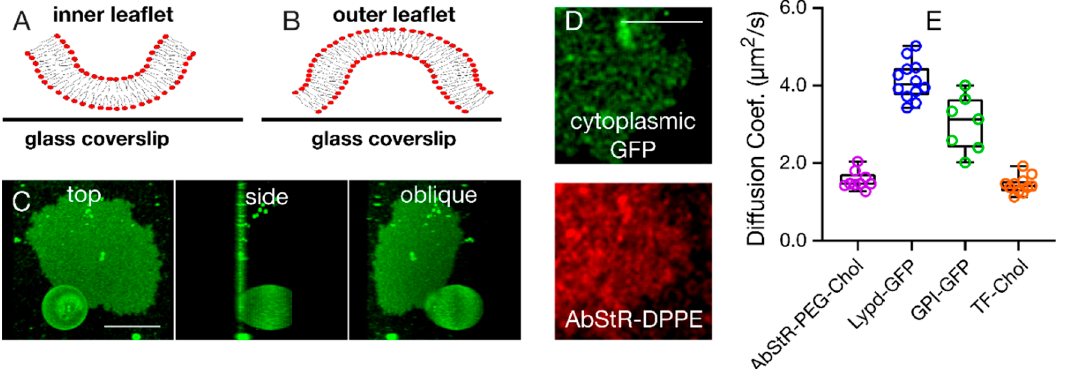
Figure 3. Bursting topology of SPMBs upon application of the acoustic field. ( A , B ) Inside-out (A, inner leaflet is facing upwards and is thus accessible) and outside-out bursting ( B ) (outer leaflet is facing upwards and is thus accessible) scenarios. ( C ) Representative confocal image of a SPMB with a semi-burst GPMV (right: top x-y view, middle: side y-z view, left: oblique 3D-rendering). ( D ) Confocal microscopy top view of a representative SPMB membrane-labelled with a fluorescent lipid analog (red, Abberior Star Red DPPE) and of cytoplasmic GFP expressed in cells and thus inside the GPMVs, indicating that the cytoplasmic GFP got captured underneath the bilayer upon bursting (i.e., outside-out bursting scenario). ( E ) Diffusion coefficients of various outer leaflet molecules as determined by FCS on the SPMBs. Scale bars are 10 µm.